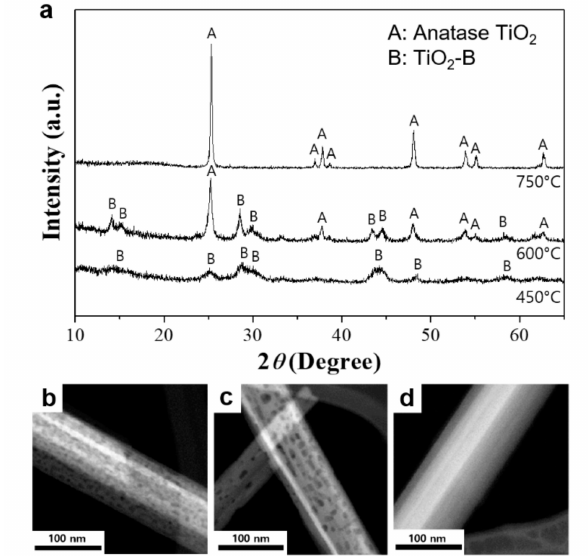
Figure 2. ( a ) XRD patterns of the TiO 2 nanobelts obtained at di ff erent calcination temperatures, TEM images of TiO 2 nanobelts obtained at ( b ) 450 ◦ C, ( c ) 600 ◦ C, and ( d ) 750 ◦